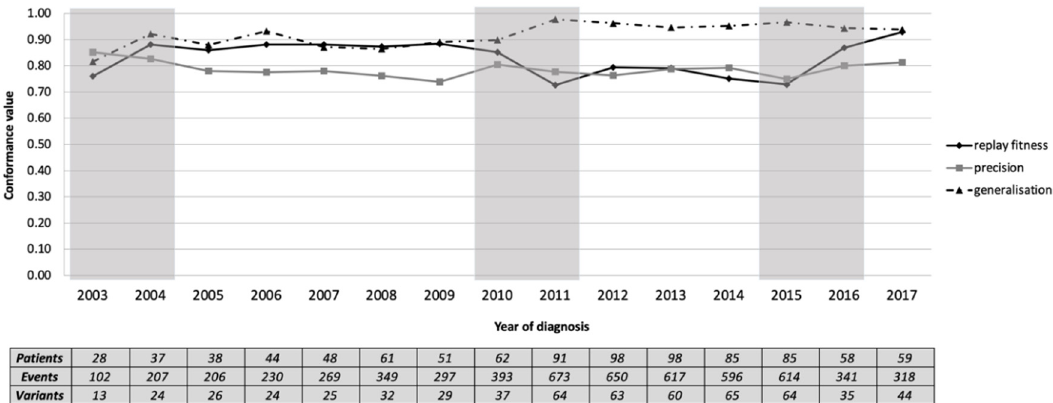
Figure 4. Annual conformance to the general process model. The shaded areas show the periods where change might have occurred at the process model level.